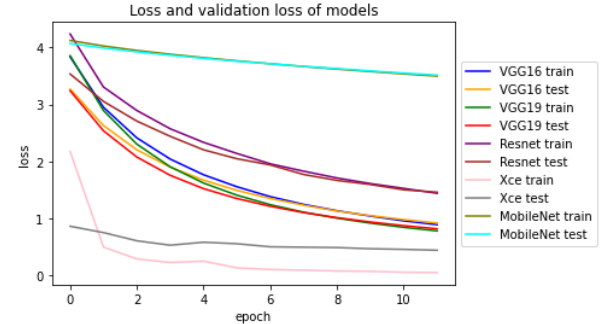
FIGURE VII. LOSS AND VALIDATION LOSS OF MODELS DATASET 2 Figure VII represent how loss (train) and validation loss